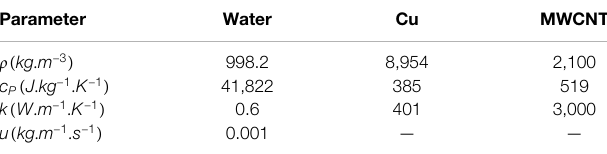
TABLE 1 | The speci fi cation of solar collector. TABLE 2 | The speci fi cation of water and nanoparticles (Abdollahzadeh et al., 2018; Nguyen et al.,